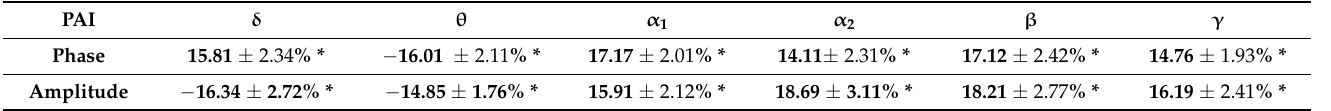
Table 3. Posterior–anterior index (PAI) for amplitude and phase